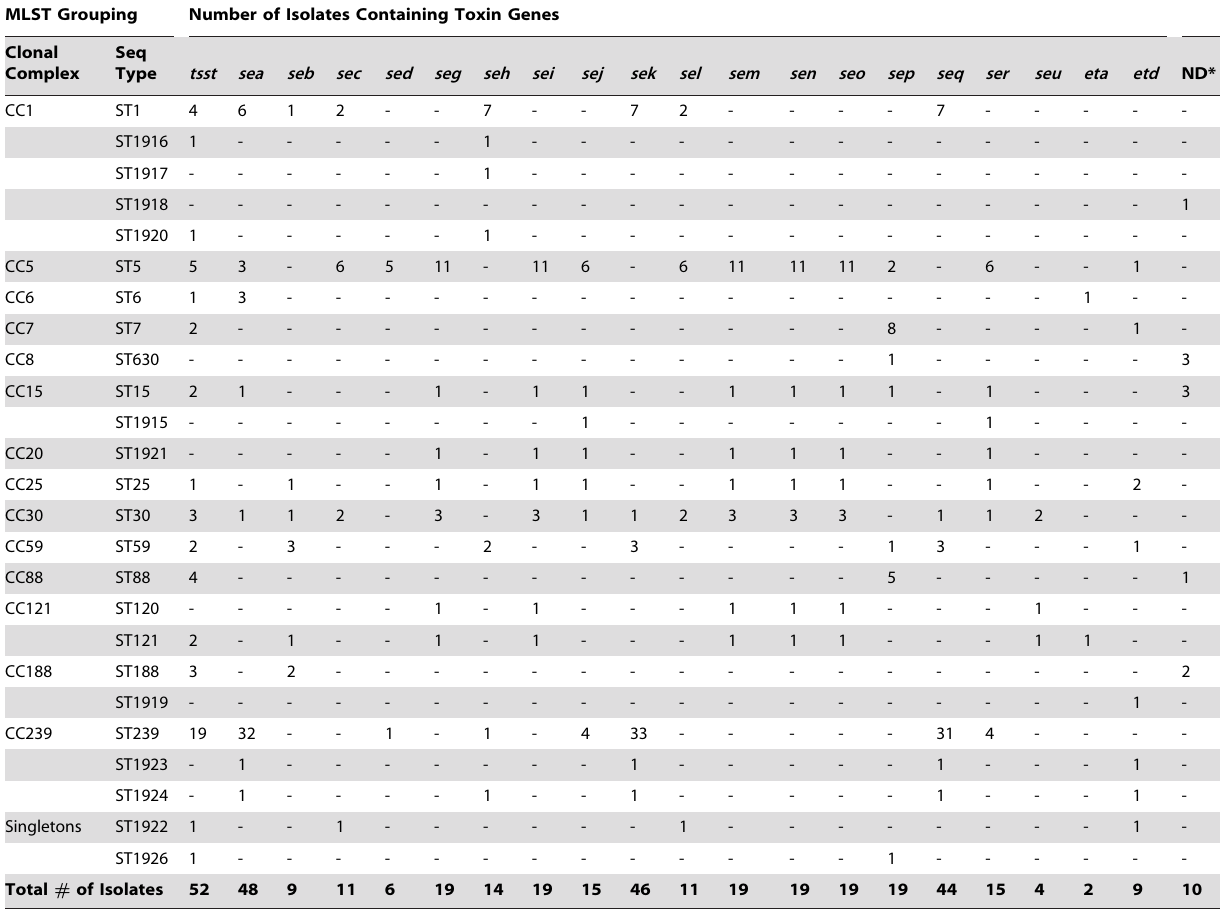
Table 2. Staphylococcus aureus clonal complexes and occurrence of toxin genes .